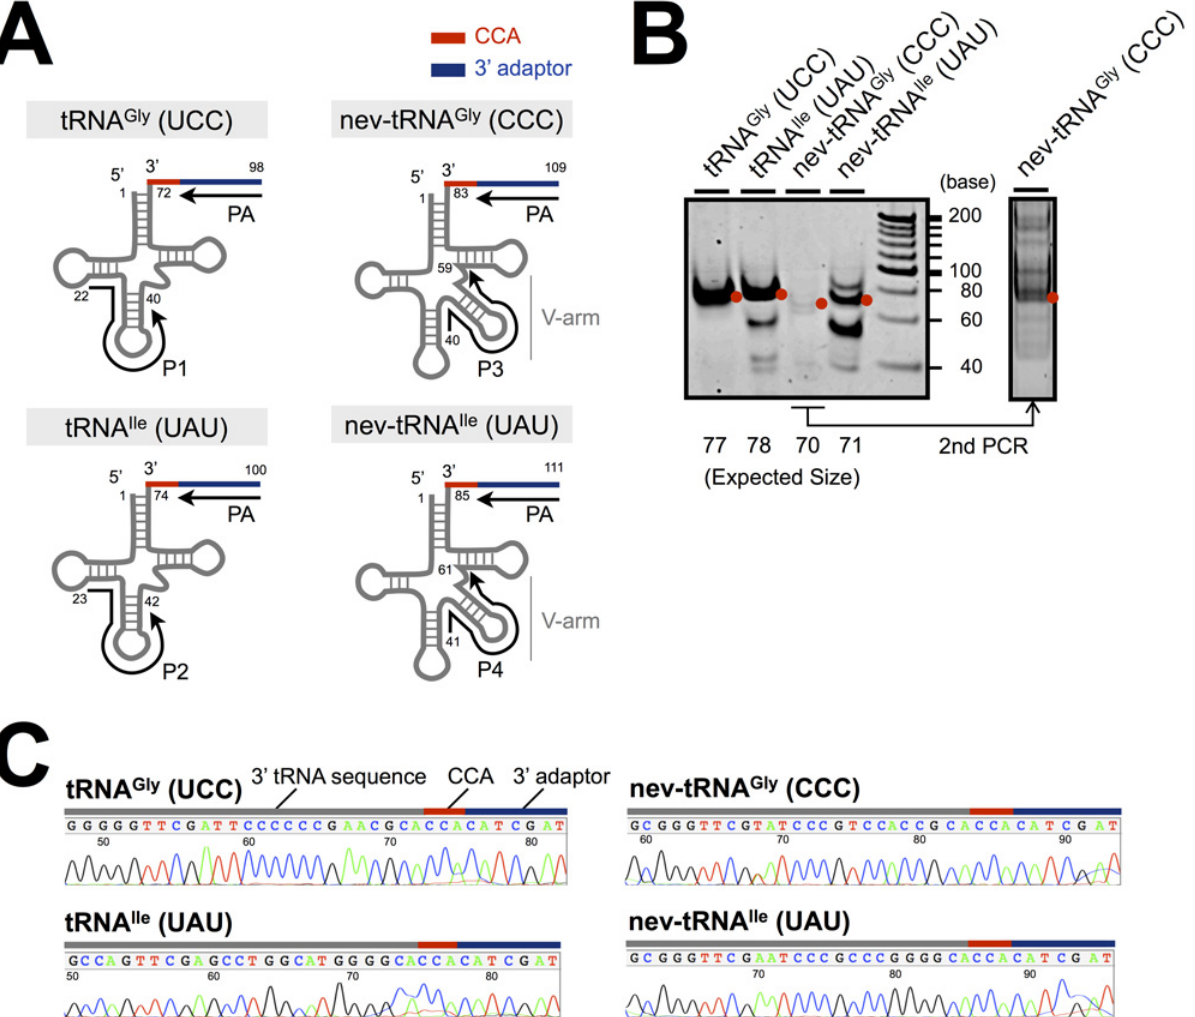
Figure 1. Detection of the 3 0 CCA end sequences of nev-tRNAs. (A) PCR scheme for the detection of the 3 0 ends of mature tRNAs: nev-tRNA Gly (CCC) and nev-tRNA Ile (UAU) and their cognates, tRNA Gly (UCC) and tRNA Ile (UAU), respectively. Numbers indicate the nucleotide positions relative to the 5 0 end of each tRNA. (B) RT – PCR amplification of the 3 0 end of each tRNA. PCR products of the expected sizes are shown as red dots. (C) Nucleotide sequence chromatograms of the 3 0 end region of each tRNA.